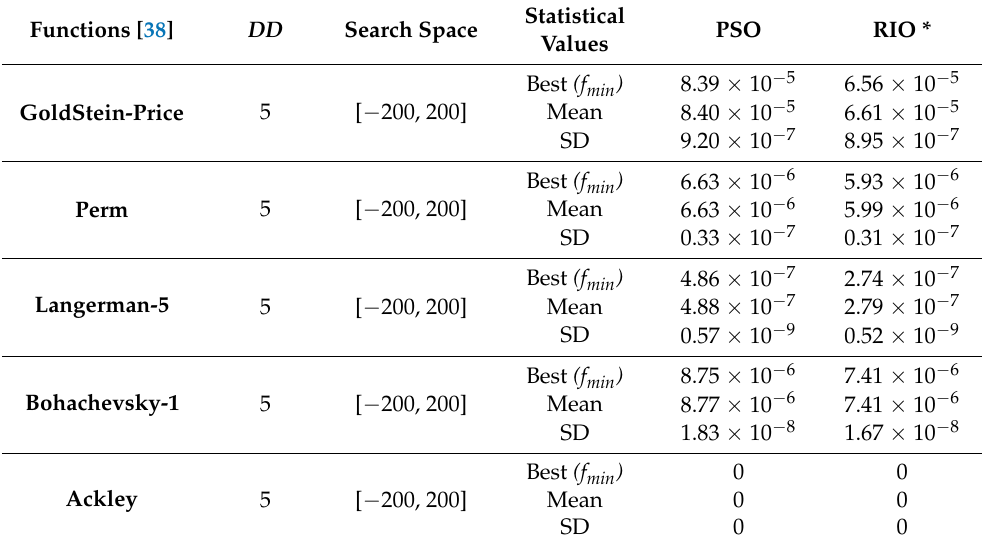
Table 6. Comparative performance indexes of different test functions. Functions [38]